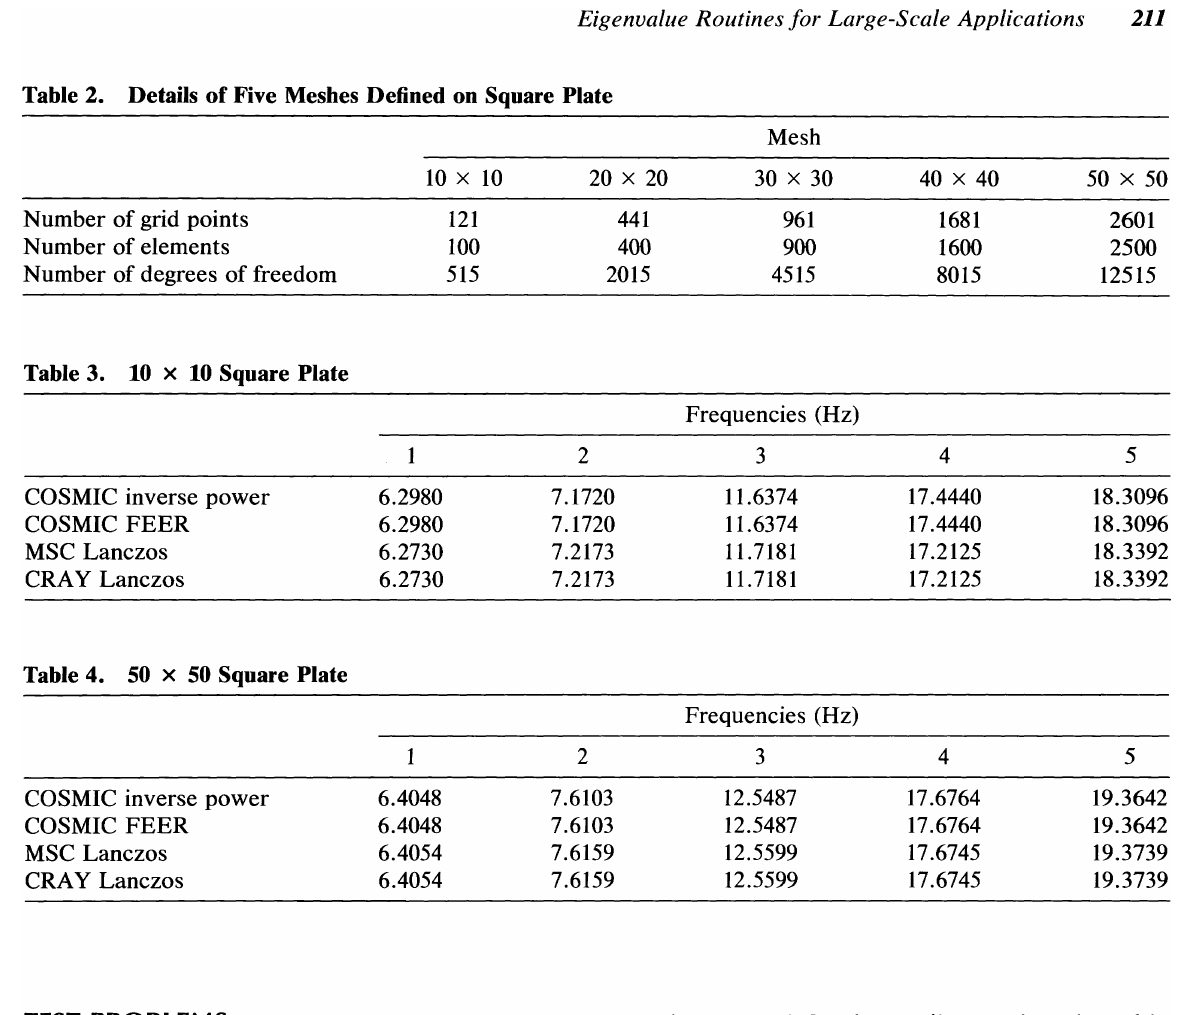
Table 2. Details of Five Meshes Defined on Square Plate